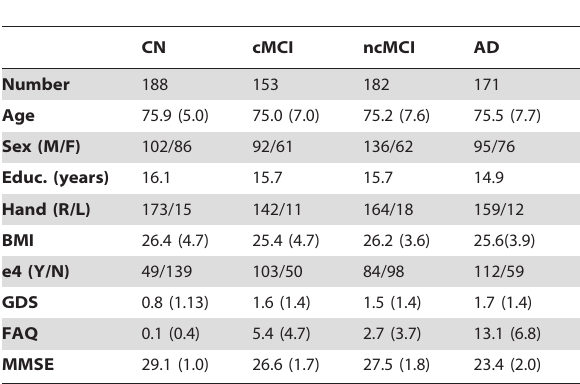
Table 1. Demographic data for the 694 ADNI participants, shown across categories of clinical